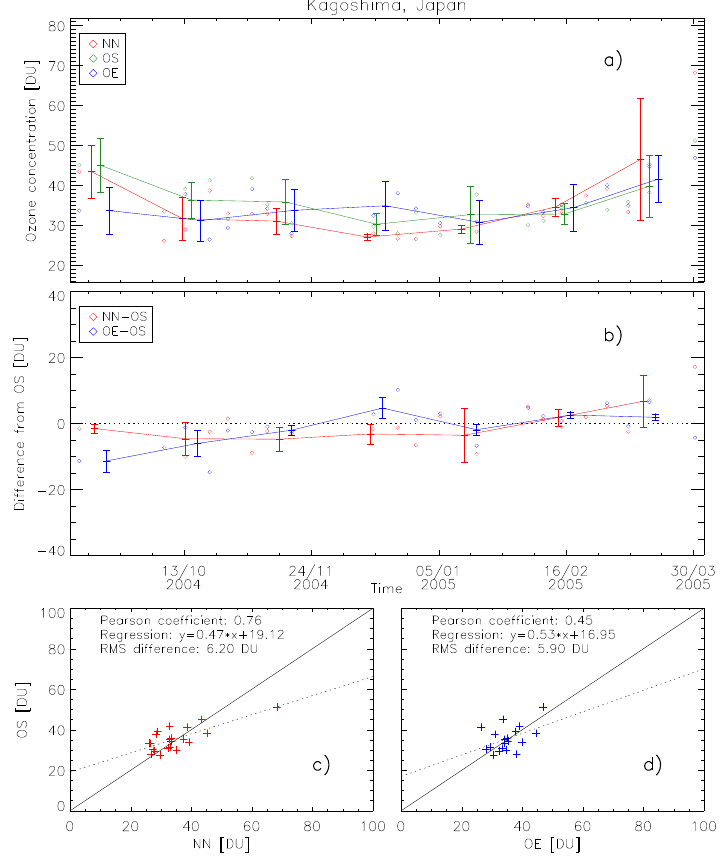
Fig. 9. Time series of OMI-TOC NN (in red) and OE (in blue) retrievals, and OS reference data (in green) (a) ; time series of absolute differences between OMI-TOC NN retrievals and OS (in red), and OE retrievals and OS (in blue). A monthly mean is over plotted (crosses with errorbars and lines) (b) ; scatter plot of OMI-TOC NN retrievals (in red) and OE (in blue) versus corresponding OS true data (c) , (d) for Kagoshima, Japan.